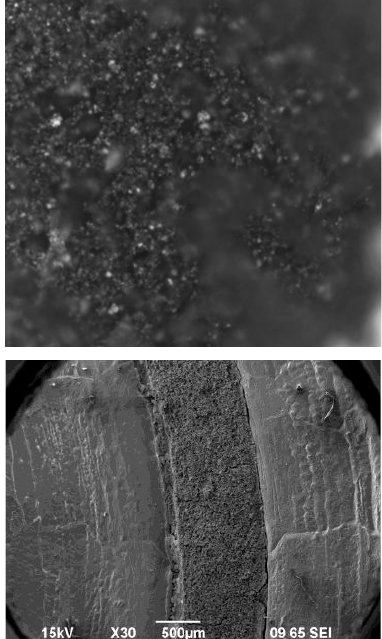
Fig. 4. Microphotographs of emitter surface using light and electronic microscopes